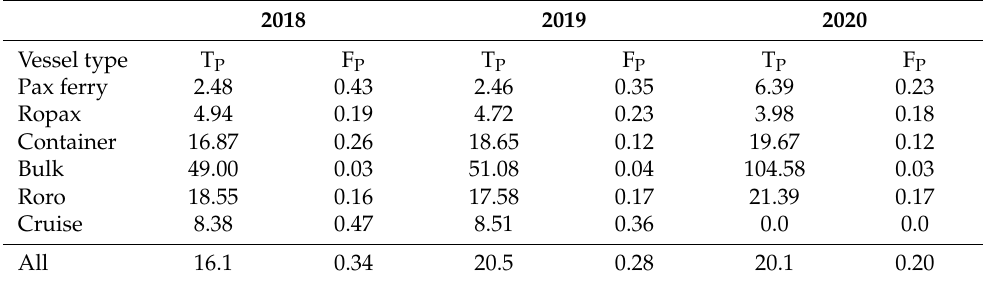
Table 3. Mean time in port in hours (T P ), mean fuel consumption in port in metric tons per hour (F P ) by vessel type at port of Helsinki 2018–2020. Time in port by vessel type was calculated from the port arrival and departure data and fuel consumption in port from the MRV data.